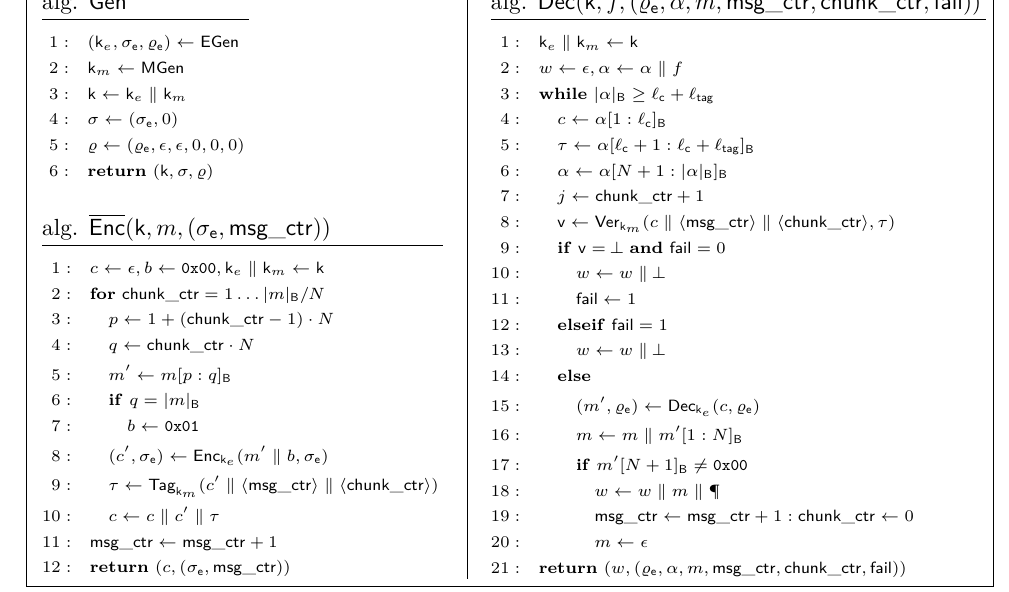
Figure 8: A byte-oriented version of the original InterMAC scheme, oIM